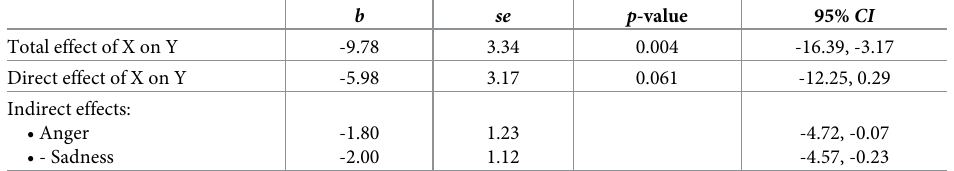
Table 4. Total, direct and indirect effects on the relation between perceived discrimination (X) and mental health (Y) via emotional responses (i.e. anger and